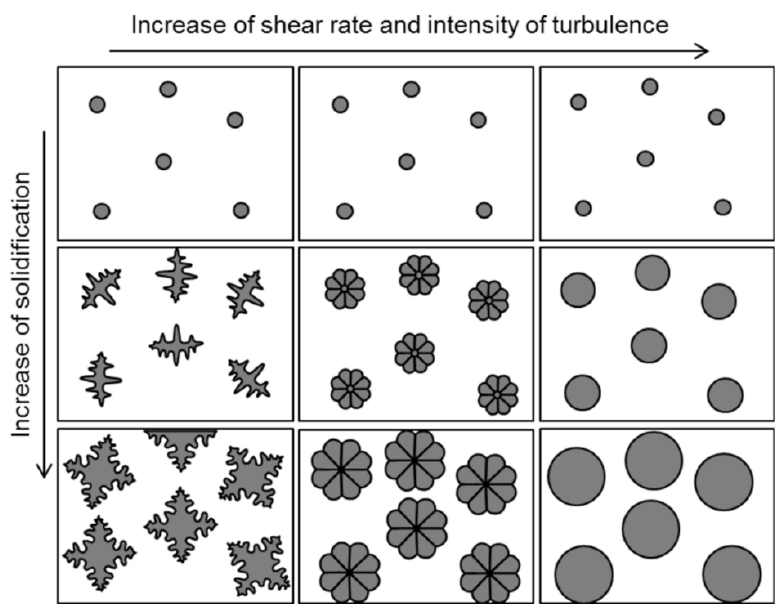
Figure 19. Schematic illustration of morphological transition from dendritic to spherical via rosette with increase in shear rate and intensity of turbulence. Reprinted with permission from Ref. [183].